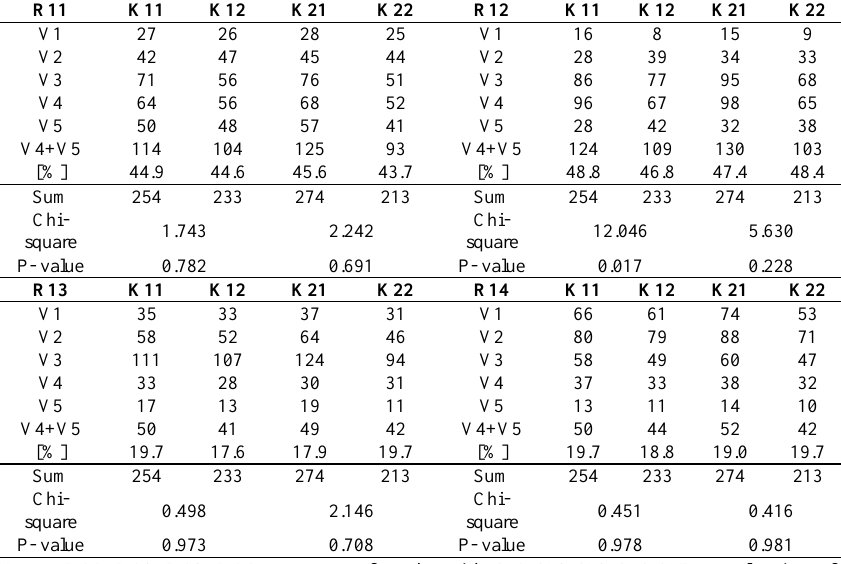
Table 1. The evaluation of sources of market risk by entrepreneurs